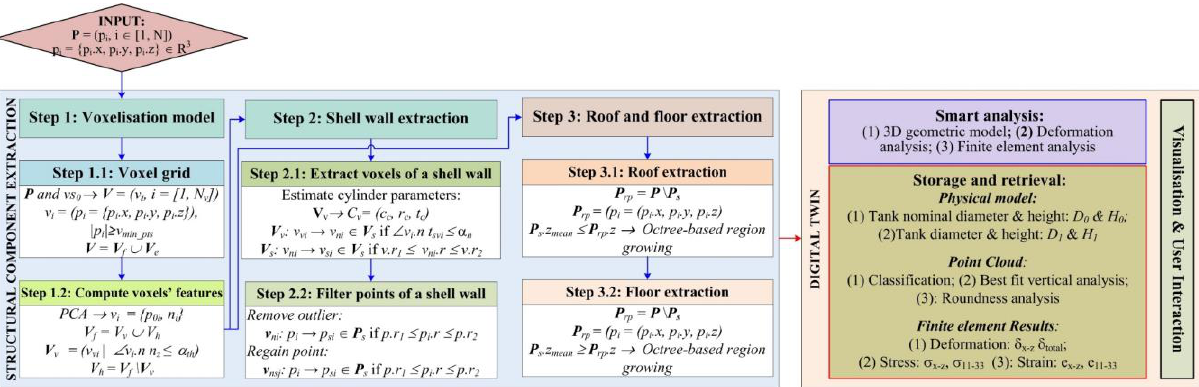
Figure 1 . A framework to create a digital twin of a storage tank